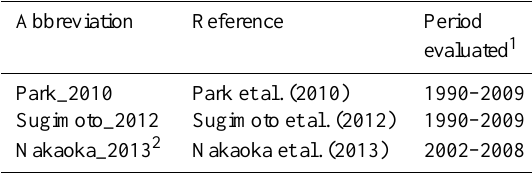
Table 1. List of diagnostic models included in this